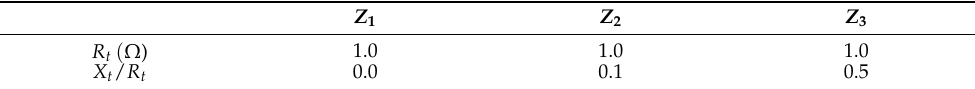
Table 3. Equivalent system impedance parameters.